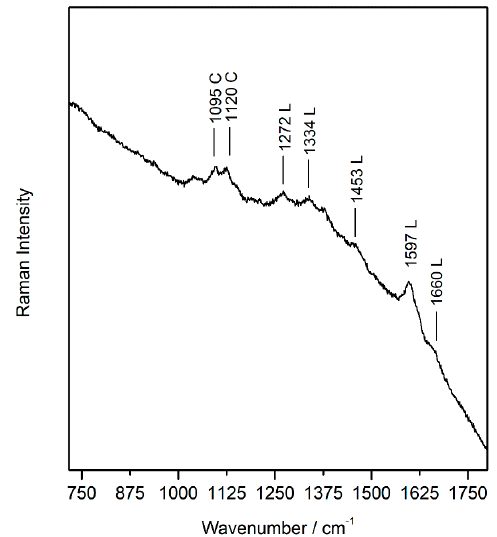
Figure 6. Raman spectrum of paper support where bands of cellulose (C) and lignin are shown (L) (sample wp5). In Figure 6, two bands belonging to cellulose were visible located at 1095 cm − 1 (C–O– C of β -glycosidic linkage of cellulose and hemicellulose) and at 1120 cm − 1 (C–O–C of the α -glycosidic linkage of hemicellulose). Generally, the aging processes of cellulose favor the partial breaking of the α -glycosidic and β -glycosidic. In particular, as demonstrated by previous research, a decrease in the intensity of the band corresponding to the α -gly- cosidic bond, compared to the β -glycosidic bond can occur, because it is a weaker link, therefore, the hemicellulose seems to be more sensitive to degradation processes [36]. In addition to the cellulose Raman bands, those belonging to lignin were evident, although very weak, with the most intense one at 1597 cm − 1 corresponding to the symmet- ric aromatic ring stretch. All the Raman bands of lignin (1272, 1334, 1453, 1597, and 1660 cm − 1 ) present in the Raman spectrum recorded in the samples have been reported in the study of Agarwal et al. [37] for the spectrum of spruce milled-wood lignin (MWL). The presence of lignin in the paper matrix could be one of the causes of the cellulose oxidation, due to its acidic nature, which was visible by the naked eye like a yellowing (Figure S5). For this reason, nowadays, lignin is removed from cellulosic pulp before the manufactur- ing process of paper. In addition, the absence of some Raman bands at 2893 and 2936 cm − 1 could be attributed to the aging of cellulose as reported in another investigation [38]. In order to verify the pH of the paper support, some analyses with a pH-meter were carried out in the yellowed areas. Ten points were considered, and the average of the values ob- tained was between 4.23 and 5.57, in the most yellowed and in the best preserved areas, respectively, confirming an acid pH of the cellulose support. This fact suggested an im- portant degradation process of cellulose underling the loss of effectiveness of the alkaline reserve.